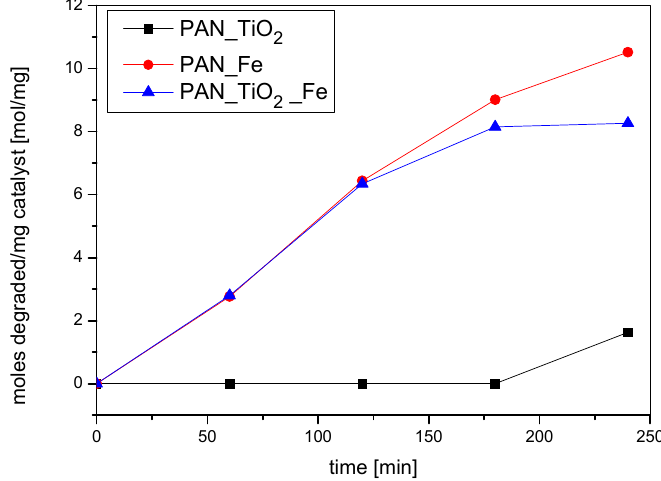
Figure 10. Formaldehyde degraded per mg of catalyst for heterogeneous photo-Fenton (PAN_Fe), photocatalytic (PAN_TiO 2 ) and their combination (PAN_TiO 2 _Fe) catalysts.